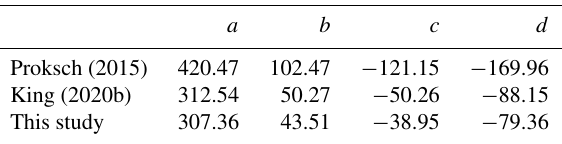
Table A1. Coefficients used to calculate density from SMP mea-